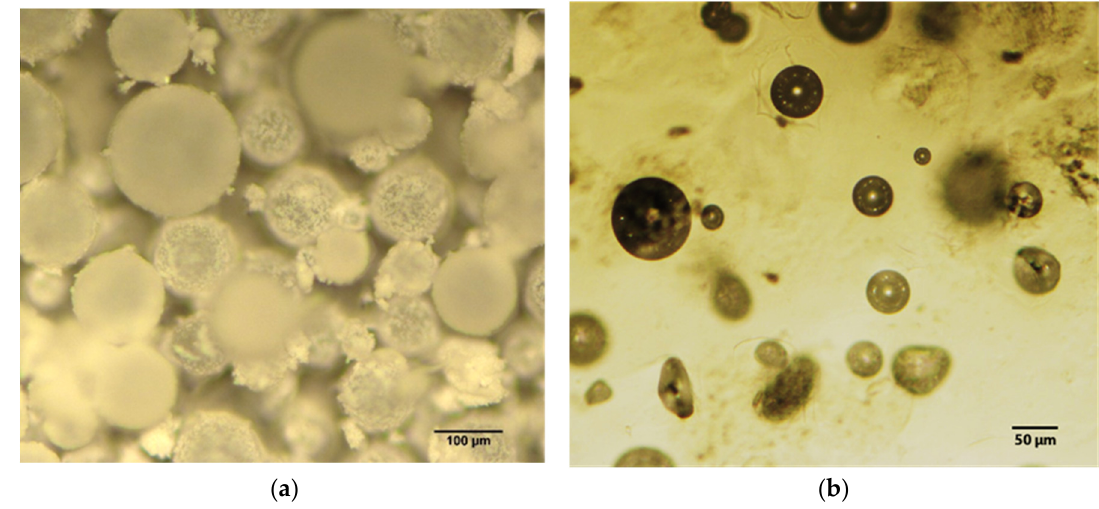
Figure 4. ( a ) Post-production optical microscopy image of SH capsules; ( b ) image SH capsules embedded in water-clear epoxy